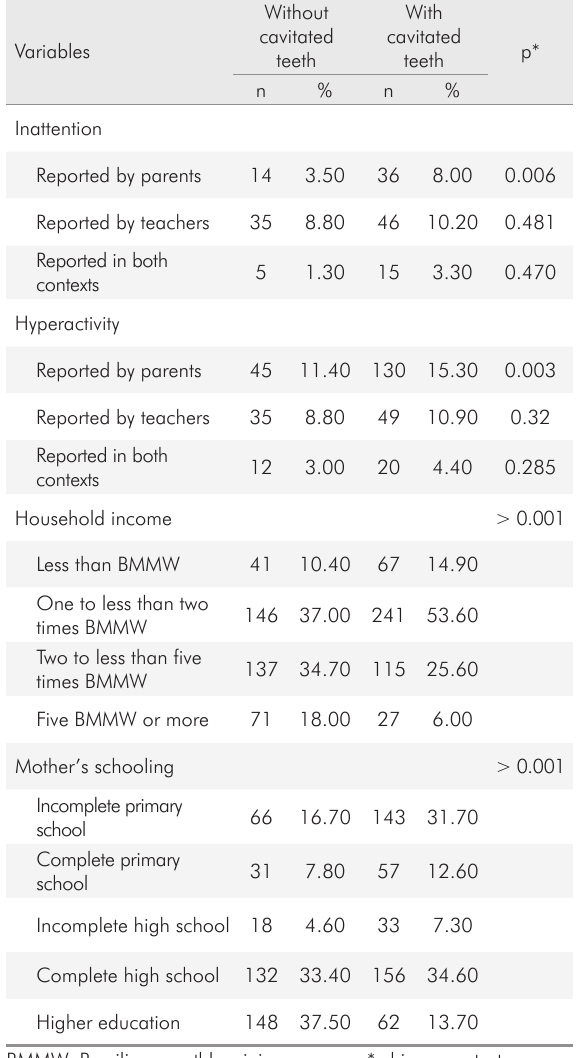
Table 3. Association between variables and occurrence of cavitated teeth